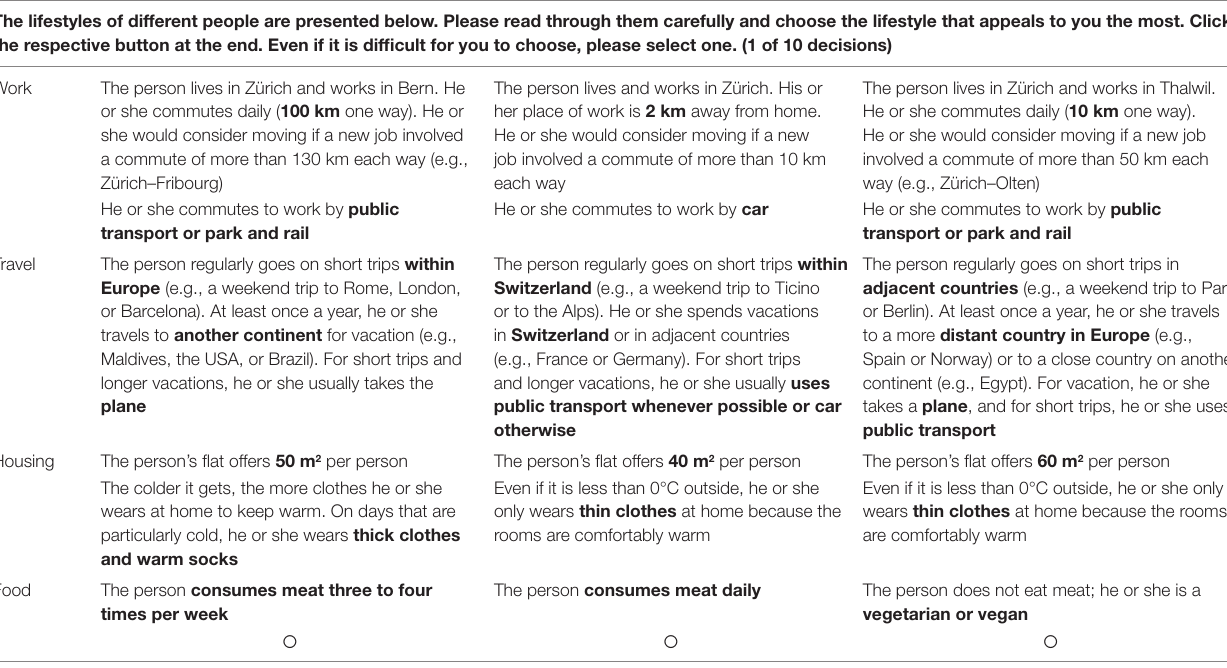
Bolded phrases were depicted in red, and the original descriptions were in German.